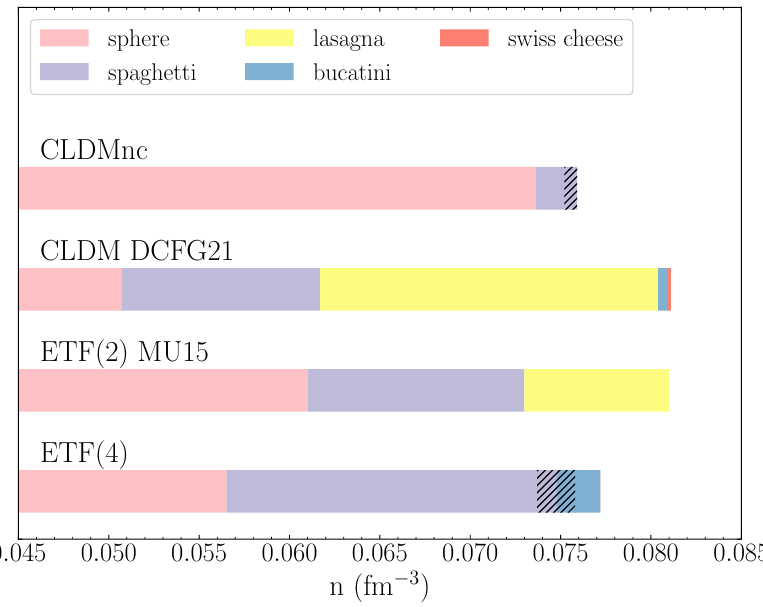
Figure 5. Sequence of pasta phases in the mantle of NS. Pink region represents spheres, violet denotes spaghetti, yellow indicates lasagna, blue is for bucatini and red is for Swiss cheese. The fourth-order ETF calculations (ETF(4)) and CLDMnc of this work are presented. The CLDM model of [41] (DCFG21) and second-order ETF results [ETF(2)] of [28] (MU15) were added for comparison. For ETF(4) and CLDMnc, we also indicate a density jump between phases according to Maxwell construction (the hatched region); only jumps visible on the scale of the plot are